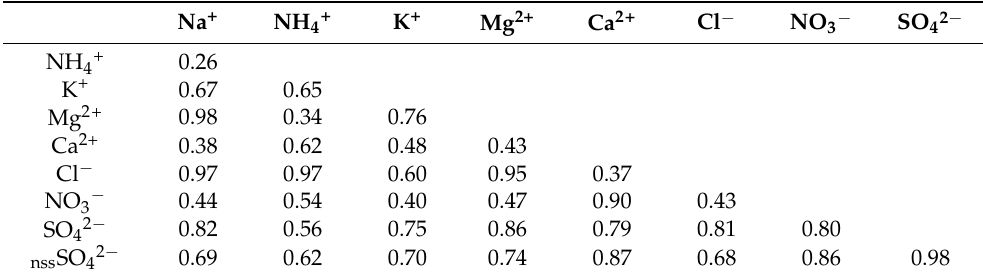
Table 2. Correlation coefficients of each ion in the